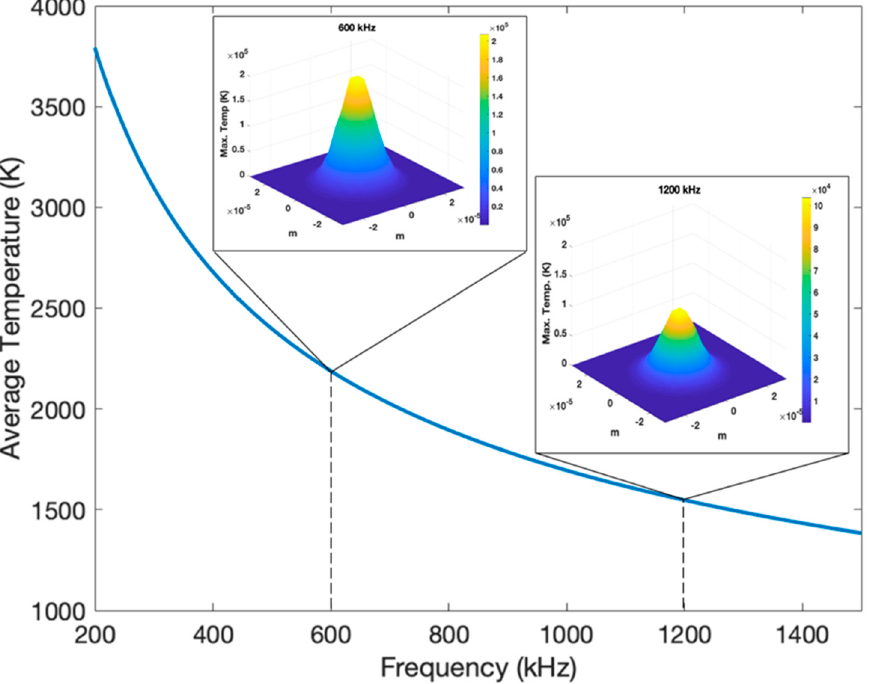
Figure 3. Theoretical results for the average and maximum surface temperature at varied pulse frequencies.